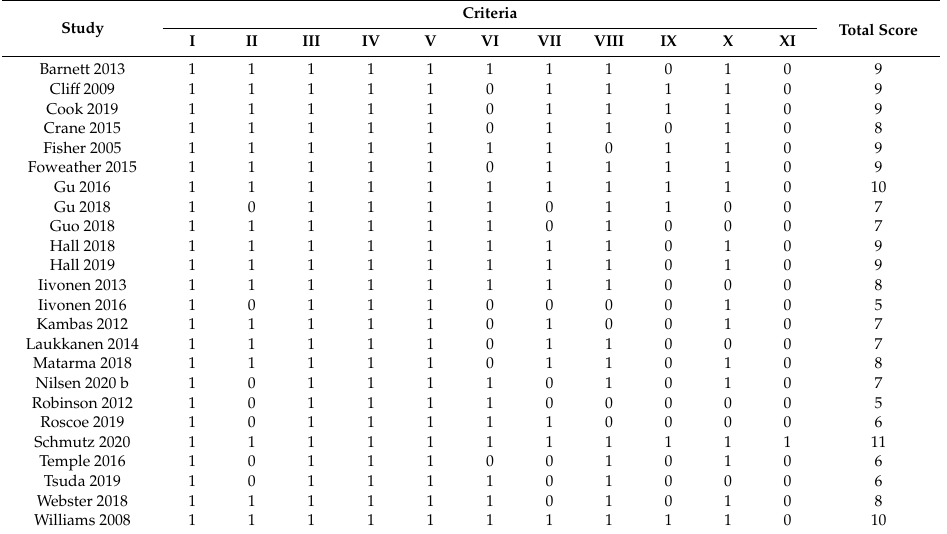
Table 2. Methodological quality assessment of included cross-sectional studies.